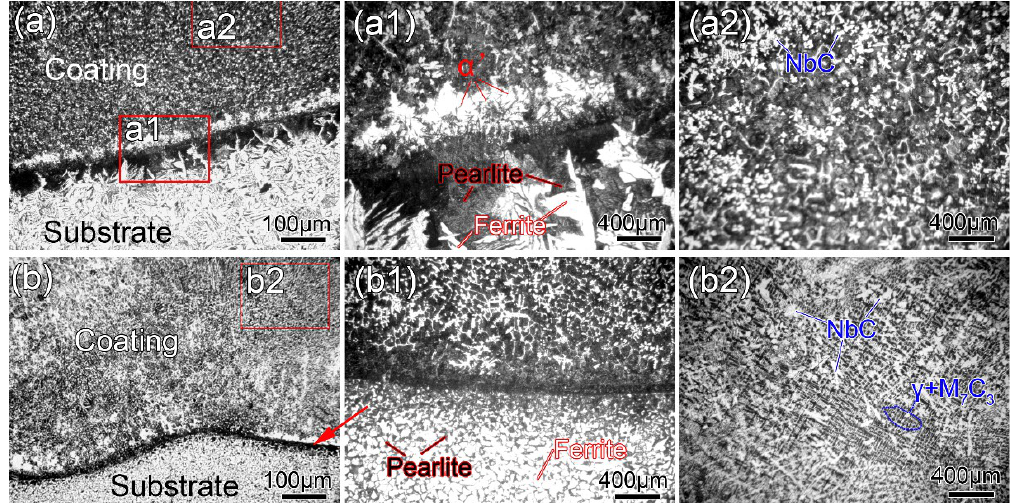
Figure 2. Optical micrographs observed from cross-sectional view of Alloy A ( a ) and Alloy E ( b ). (a1, a2, b1, b2) are the corresponding high-magnification images of the local areas within a and b, respectively.